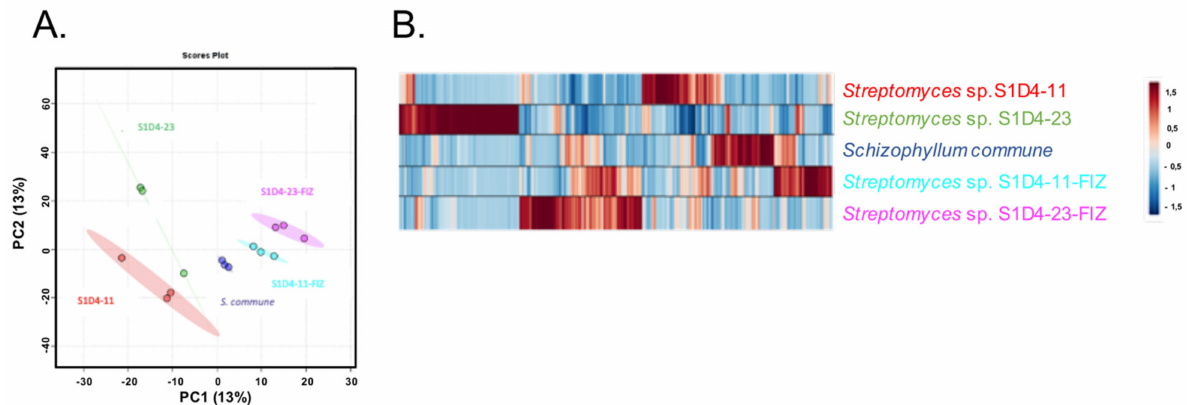
Figure 3. Gas chromatography-mass spectrometry (GC-MS) spectrum comparison. ( A ) Partial least square-discriminant analysis (PLS-DA)comparison of GC-MS spectra of mono- and co-cultures. ( B ) Heat-map of the first 750 discriminant features (26%) revealed by PLS-DA. The scale indicates the relative abundance of features calculated by centered-reduced of initial